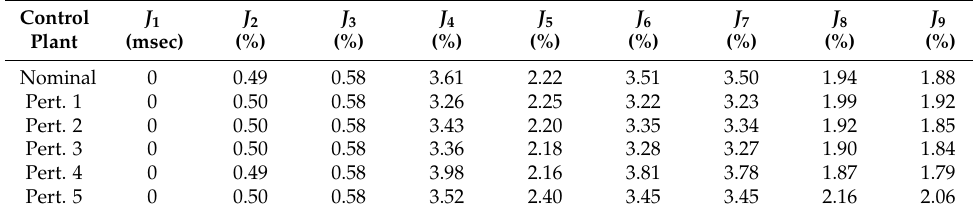
Table A1. Evaluation criteria (Damaged w/ d, Kobe earthquake, Case 4).